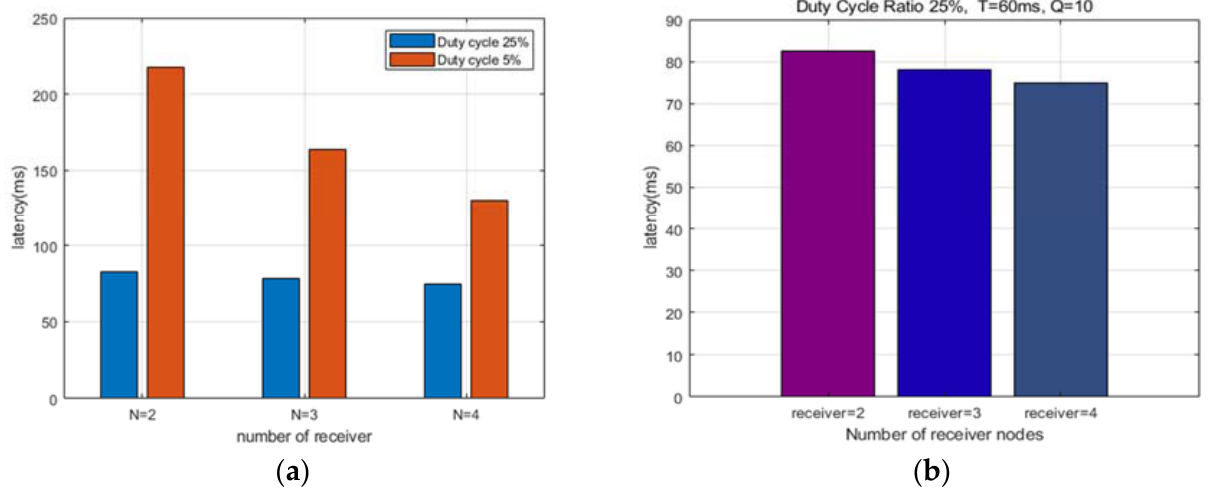
Figure 8. Comparison of latency Pre-emption MAC: ( a ) Comparison of latency according to duty cycle ratio; ( b ) Comparison of average latency according to the number of receiving